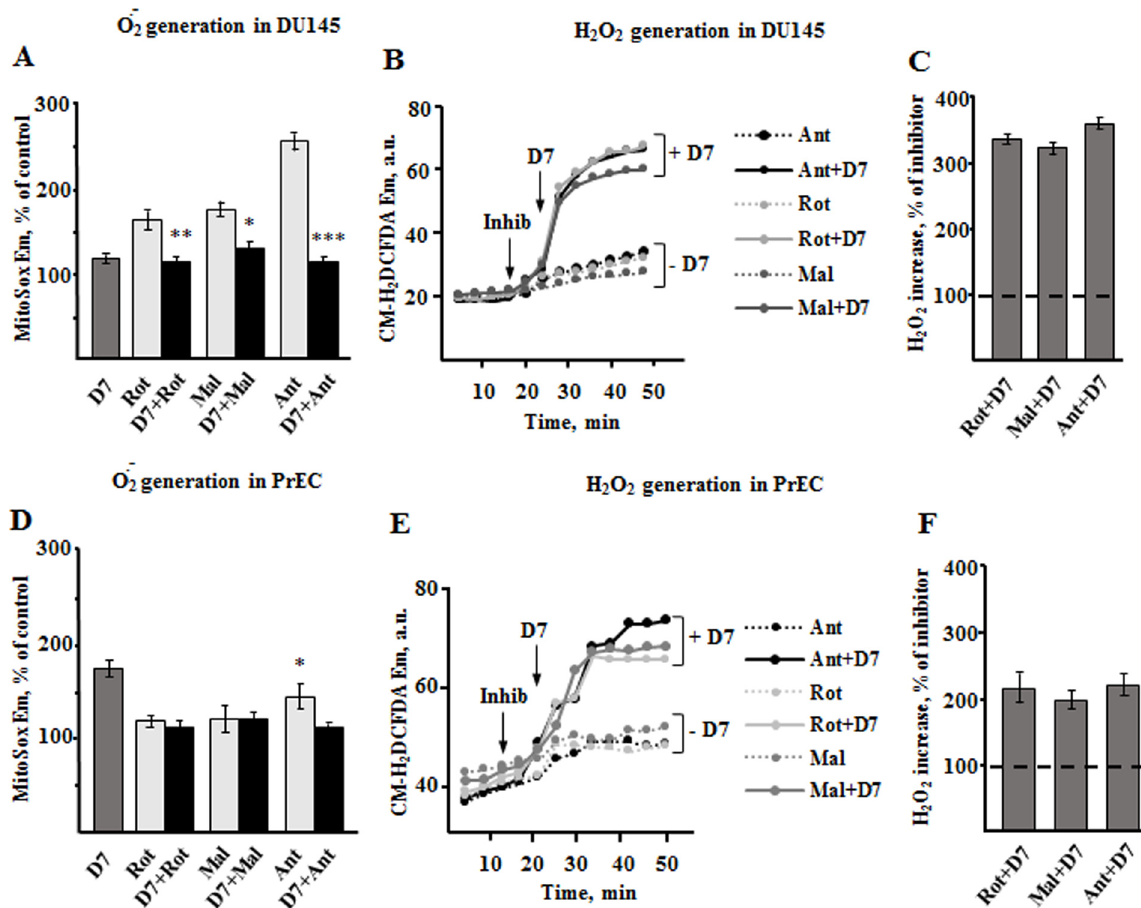
Fig 5. Non-thermal plasma induces oxidative stress in prostate cancer and normal cells. Flow cytometry measurements were performed in the presence of inhibitors of mitochondria respiratory complexes I (1 μ g/ml rotenone, Rot), II (500 μ M malonate, Mal) and III/IV (2.5 μ M antimycin, Ant). The inhibitors were used in combination with plasma treated PBS (D7) and dynamic changes of fluorescent probes ’ emission was measured for 50 minutes. ( A,D) Quantitative data of changes of MitoSox signal under modulation of cells with inhibitors and plasma treated PBS. The statistical significance is presented on top of the columns with respect to the plasma induced signal (D7). ( B,E) Dynamic changes of CM-H 2 DCFDA emission upon stimulation of cells with inhibitors and plasma treated PBS. ( C,F) Quantitative data of changes of CM-H 2 DCFDA signal. Data presented as mean ± SEM (n =